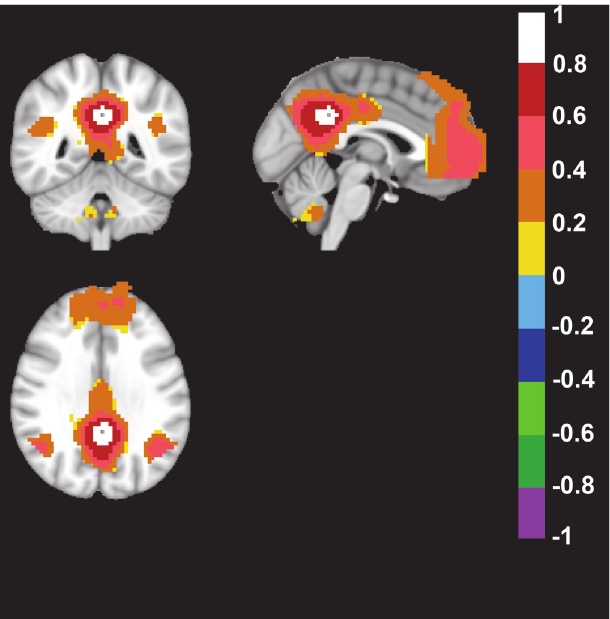
Fig 1. Human Default Mode Network. The default mode network (DMN) was derived from a seed placed in Posterior Cingulate Cortex (Talairach coordinates in mm: 0; -47; 29). Top left image displays an axial, top right a sagittal and bottom image a coronal view of the human brain. Note the color-coded positive FC-values of the DMN in the posterior cingulate/retrosplenial cortex (precuneus) and bilateral parietal cortex in the axial view. In the sagittal and coronal view note the anterior prefrontal cortex, bilateral parietal cortex and posterior cingulate/retrosplenial cortex (precuneus). FC-values are displayed with a pseudo-colored scale bar; with increments of 0.2 each designated a color (see the color-bar in the